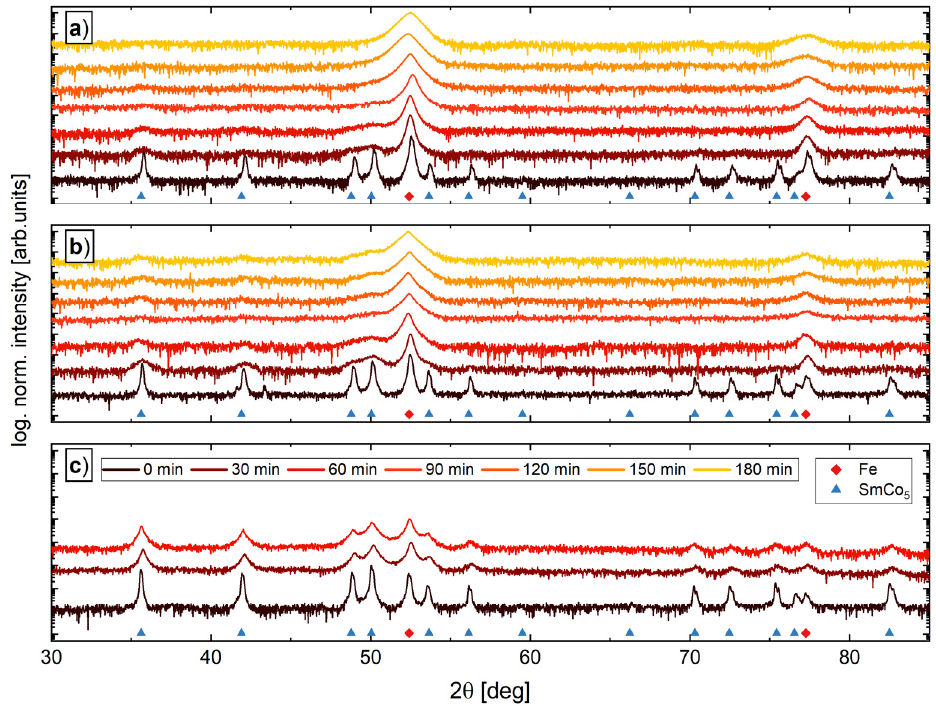
Figure 2. XRD measurements as a function of milling time for powders consisting of 66 wt.% Fe— 34 wt.% SmCo 5 ( a ), 43 wt.% Fe—57 wt.% SmCo 5 ( b ) and 26 wt.% Fe—74 wt.% SmCo 5 ( c ). The theoretical reference peaks are found in the Crystallography Open Database (SmCo 5 : COD 1524132, Fe: COD 9006587).